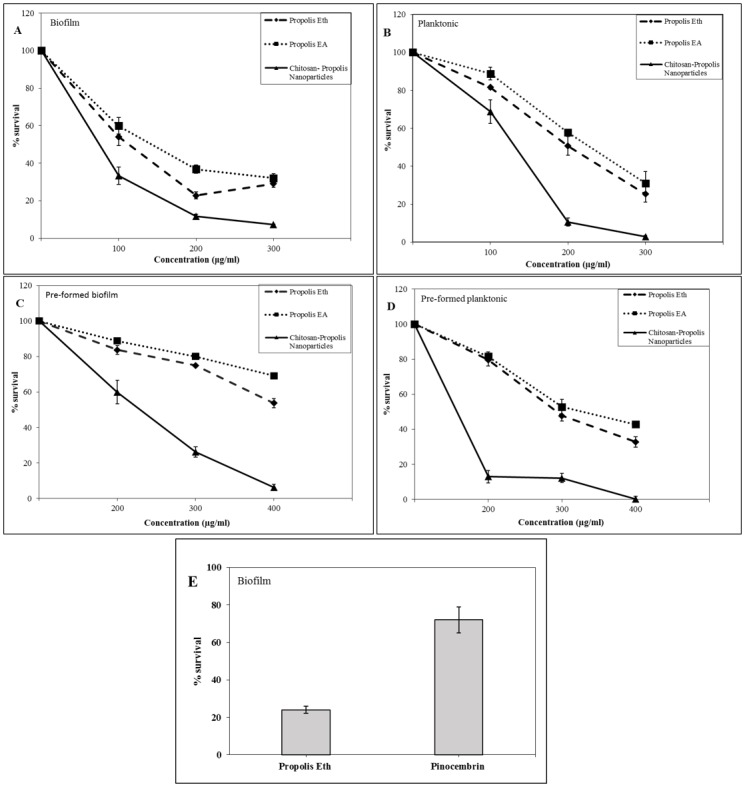
Percentage survival of bacteria in biofilm and planktonic form.Graphs describing the percentage survival of bacteria present in the biofilms (A and C) or in planktonic form (B and D) either co-treated (A and B) or pre-formed biofilm treated (C and D) with propolis Eth extract, EA extract or chitosan-propolis nanoparticle formulation F1. Graph depicting percentage survival of biofilm bacteria treated with pure pinocembrin or propolis Eth extract containing equivalent amount of pinocembrin (E).